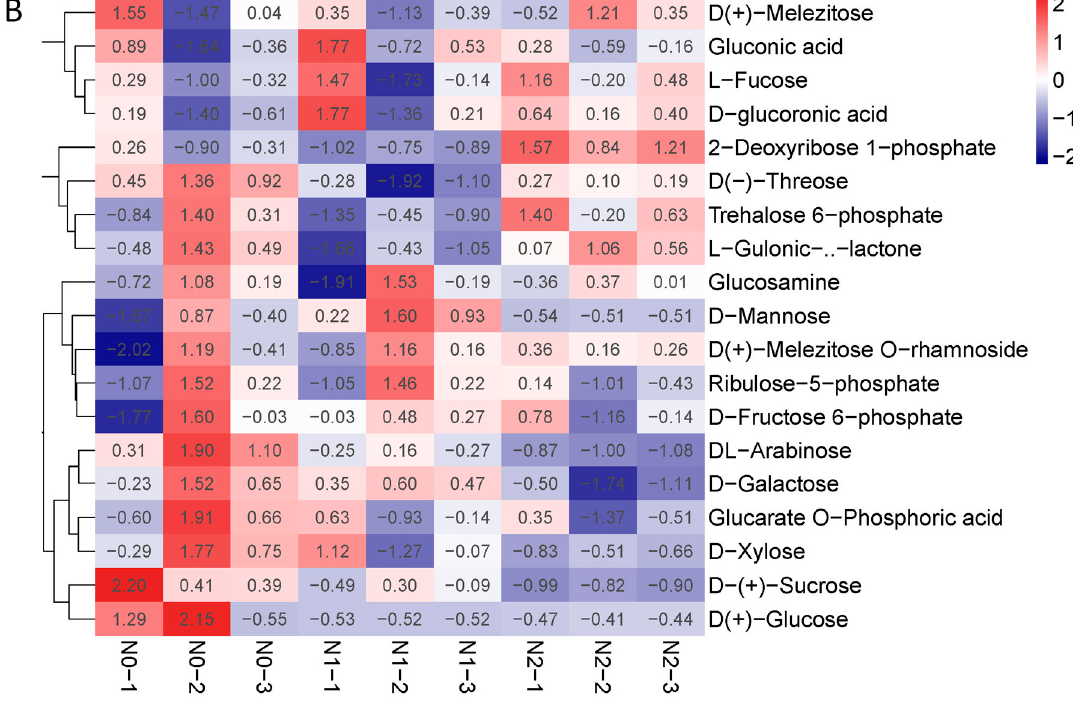
Figure 3. ( A ) Heat map of flavone metabolites of goji berry; ( B ) heat map of polysaccharide of goji berry. There is one column for each sample and one row for each metabolite. The abundance of each metabolite is represented by a bar with a specific color. The upregulated and downregulated metabolites are expressed in di ff erent shades of red and blue, respectively. As abundance increases, the color of the bar changes from blue to red. When the abundance value is 0, the color of the bar is white, as shown in the upper right-hand bar.